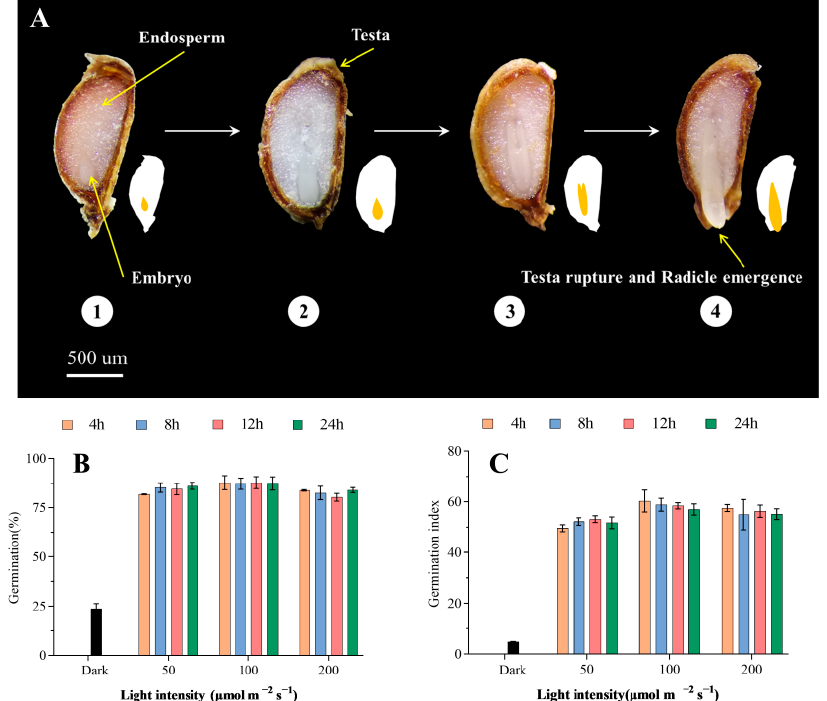
Figure 1. Effects of dark, different light intensity, and photoperiod on germination of celery seed. ( A ) Phenotypes of celery seeds under 100 μ mol m − 2 s − 1 continuous light for 1, 2, 3, 4 days. ( B ) Ger-